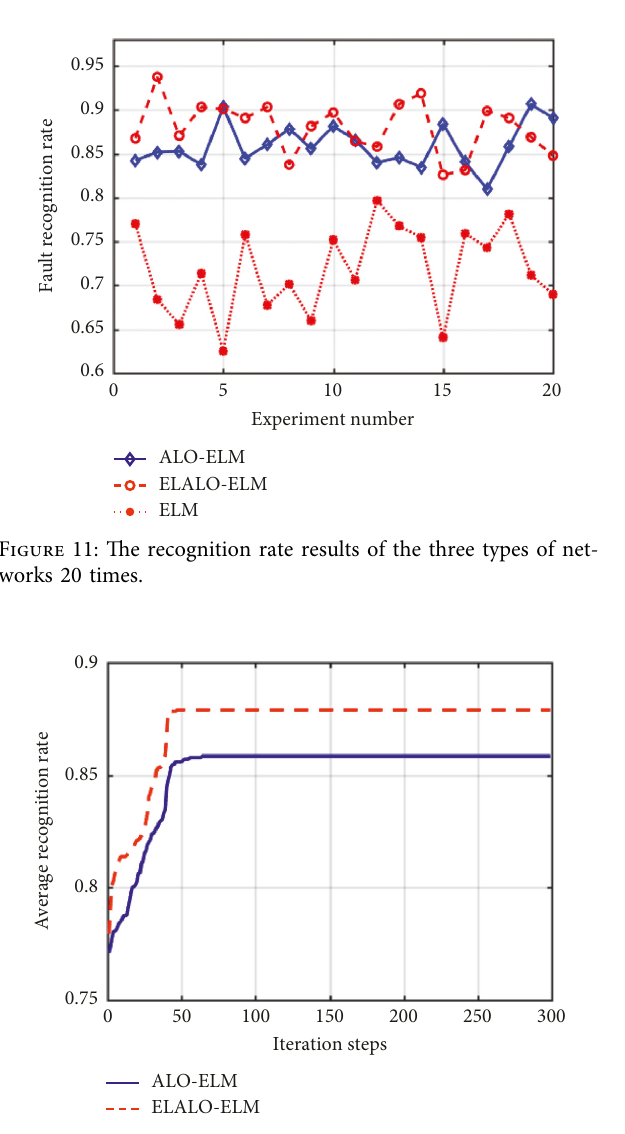
Figure 12: Comparison of two network iteration